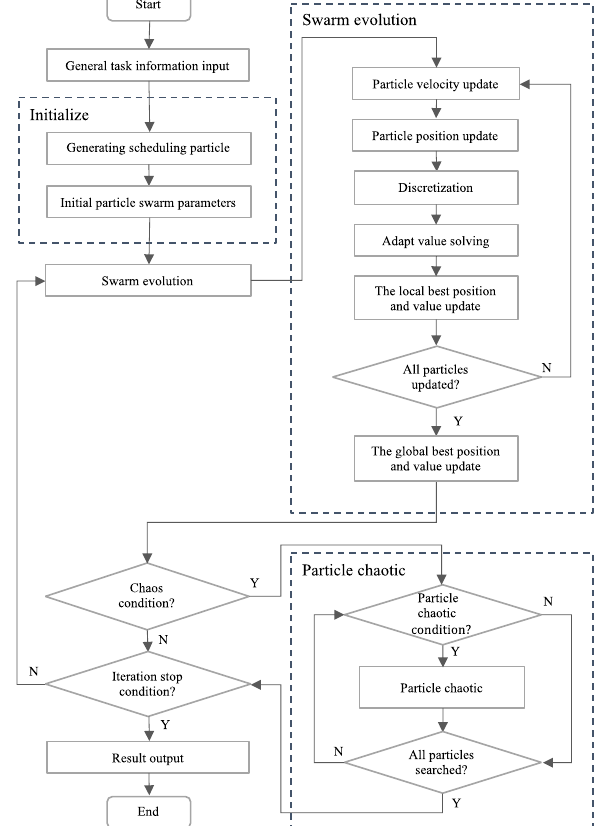
Figure 8. CCPSO flowchart.